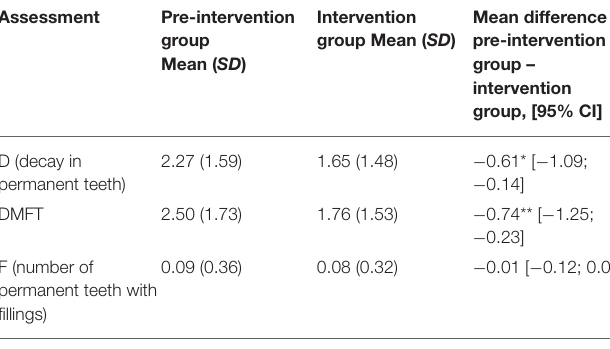
TABLE 3 | Decay levels in permanent teeth pre-intervention and four years after the start of the program among 10–11-year old schoolchildren in Karakert and Lernagog villages.